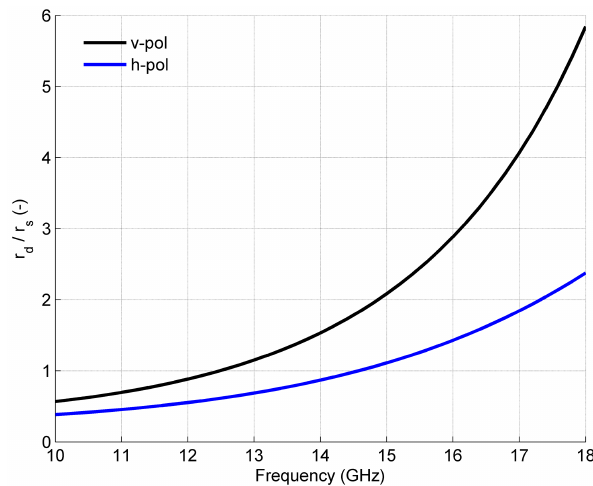
Figure 15. Ratio of the simulated diffuse ( r d ) and specular ( r s ) re- flectivity at 50 ◦ incidence angle per frequency, for the best fit pa- rameters according to Fig.